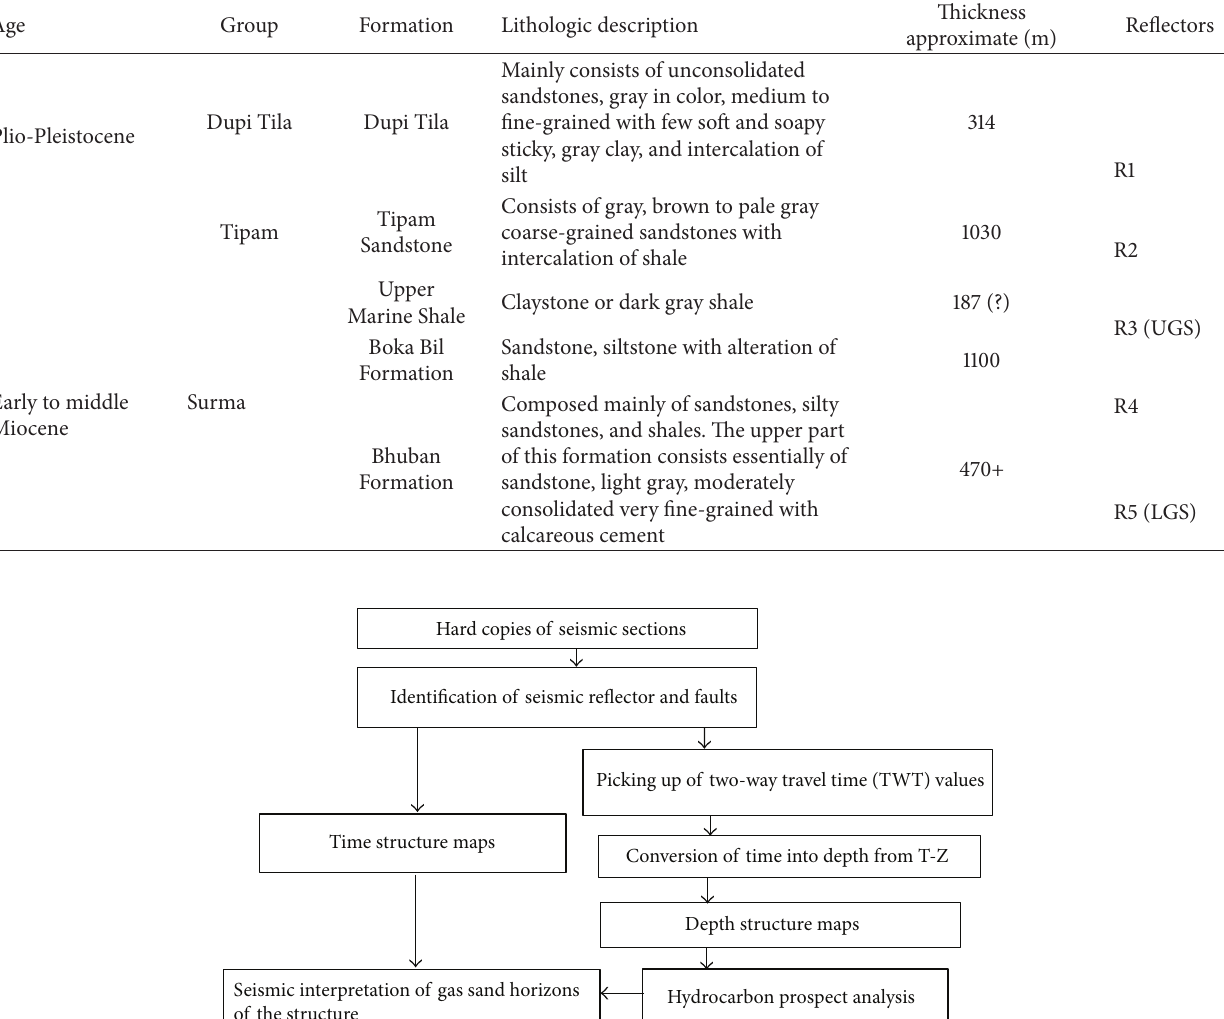
Table 1: Summarized stratigraphic succession with spatial reflectors position in the Rashidpur structure (after BOGMC [4]).